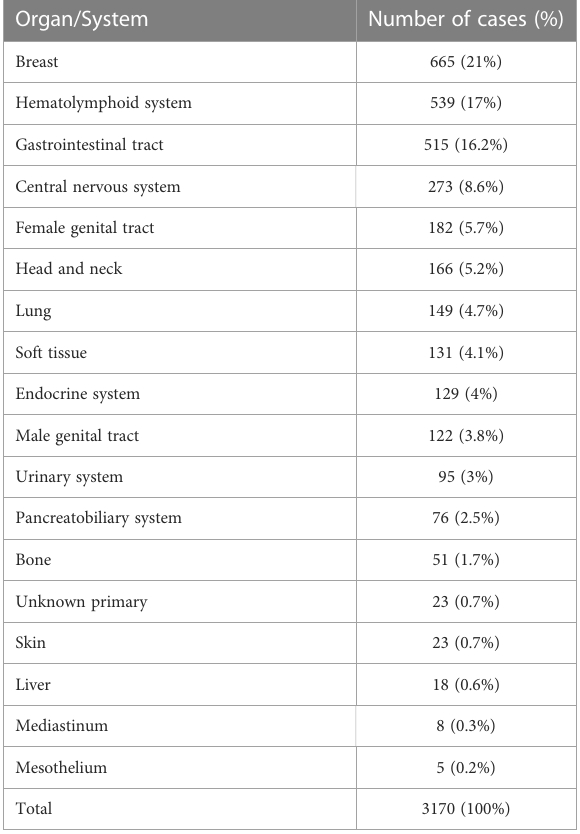
TABLE 2 Organ/system-based classi fi cation of all